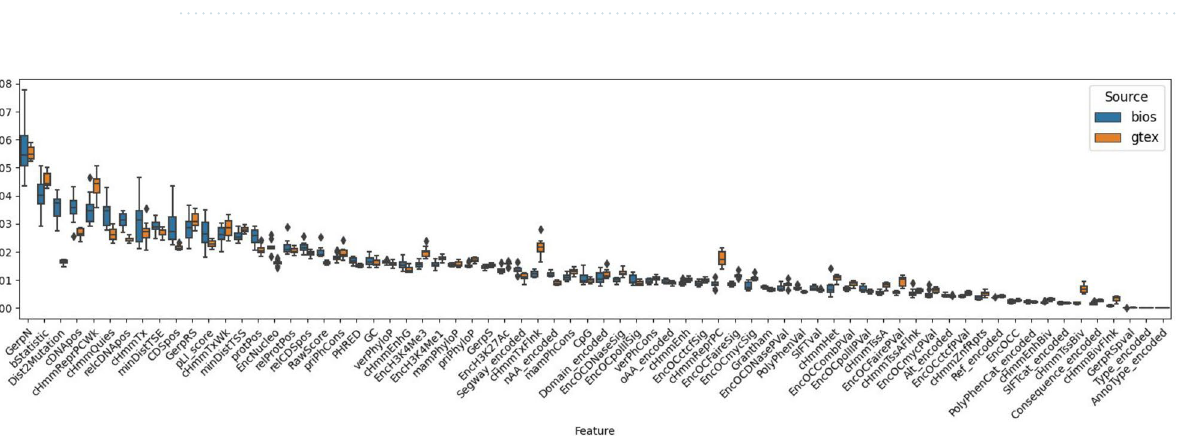
Table 1. Confusion matrix of ASE predictions across cohorts and test sets at a probability threshold of 0.5.